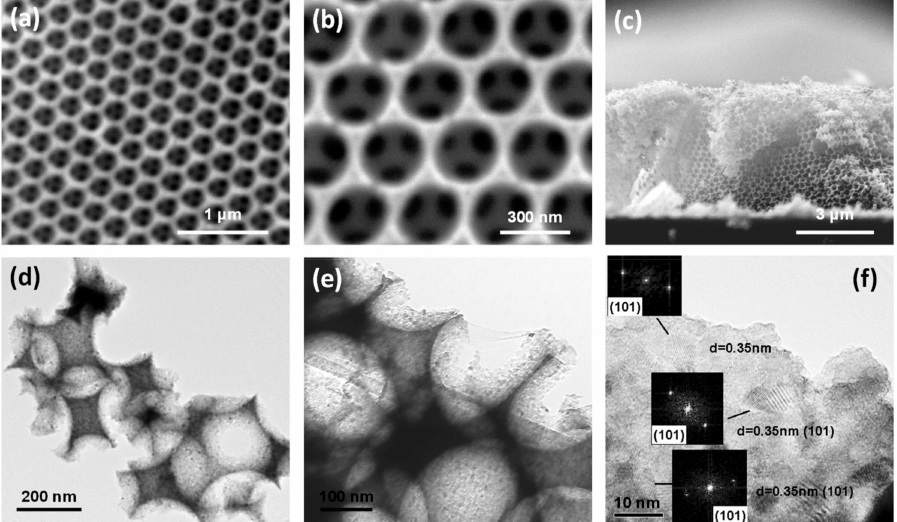
Figure 1. ( a )–( c ) Top view and cross-section SEM and ( d )–( f ) TEM images of the rGOnano(200)-PC inverse opal at di ff erent magnifications. The insets in the high-resolution TEM (HR-TEM) image ( f ) show the fast Fourier transform (FFT) patterns of the indicated